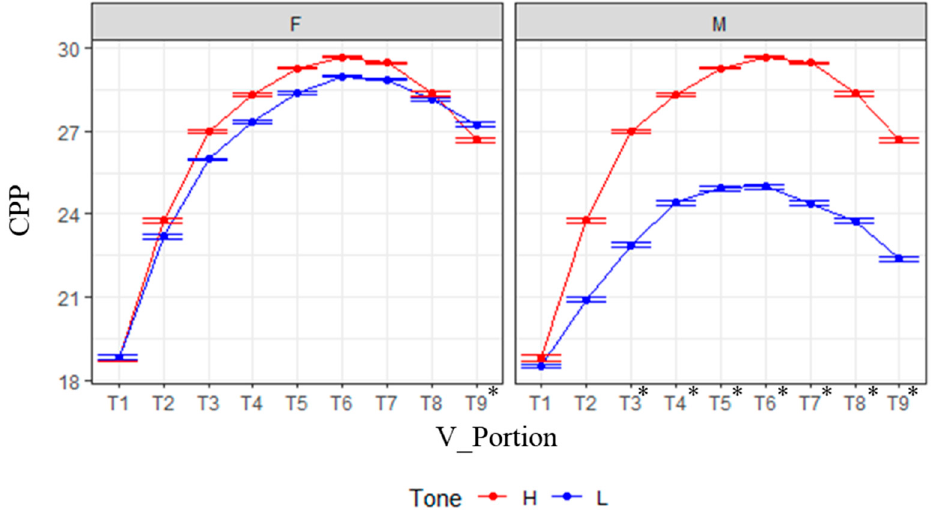
Figure 4. Scatter plots representing independent variables as a function of timepoints (T1 to T9) for CPP measure. The asterisk (*) at each timepoint indicates a significant difference in CPP values at a particular time point. F and M indicate female and male speakers’ data, respectively.